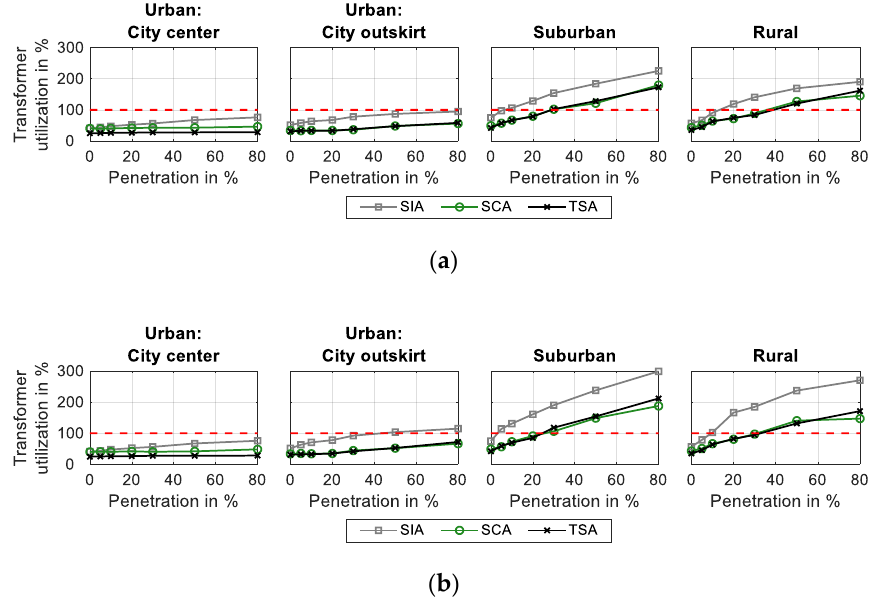
Figure 11. Maximal thermal utilization of the distribution substation’s transformer caused by CC and EV ( a ) as well as CC, EV and HP ( b ) considering various load approaches, grid regions and penetration levels.